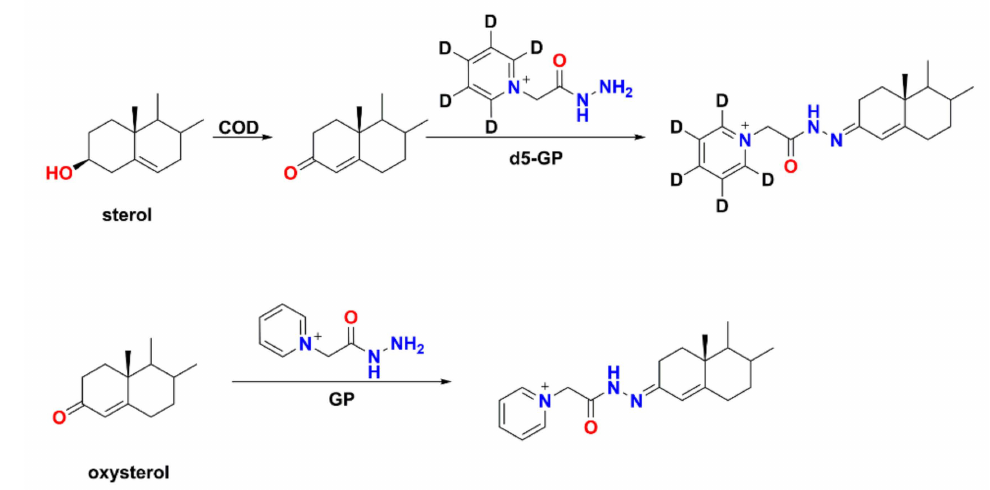
Scheme 3. Reaction strategy for simultaneous quantification of sterol and